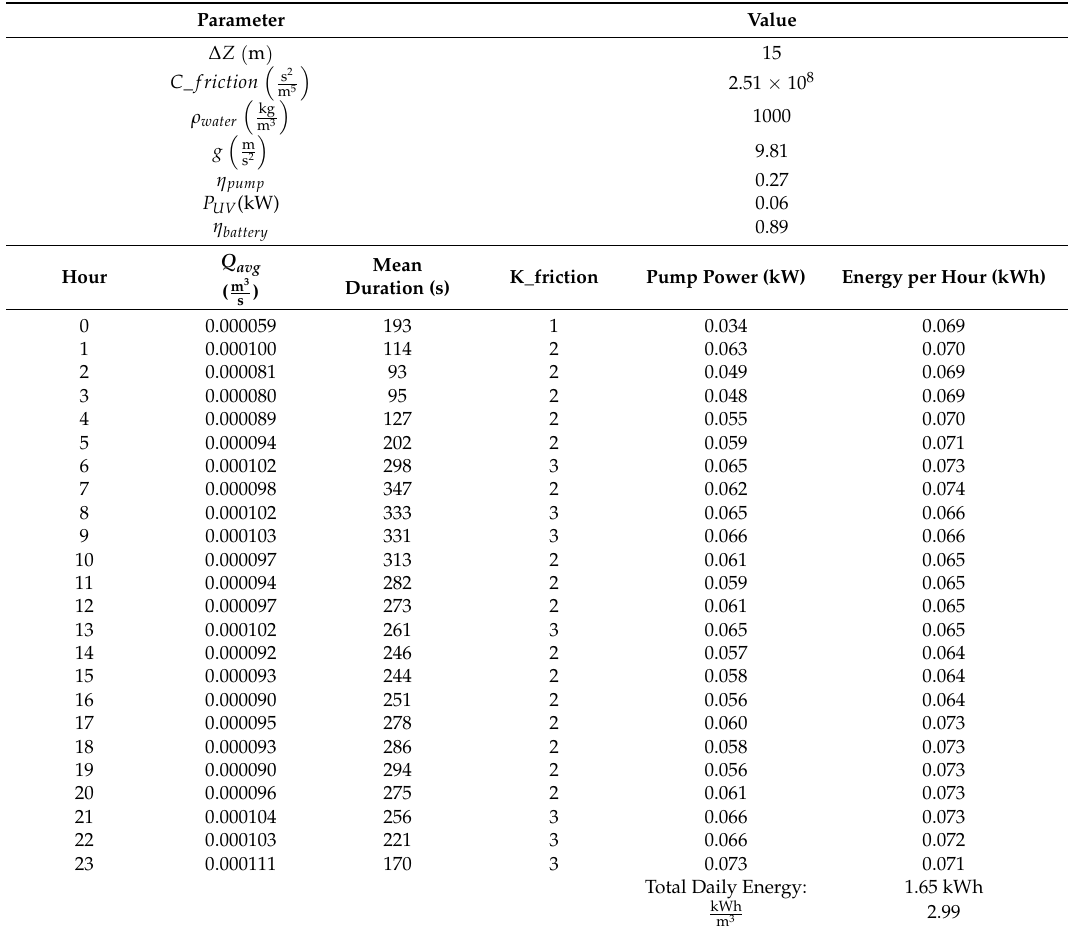
Table A4. Variable-speed pump on demand system calculations.